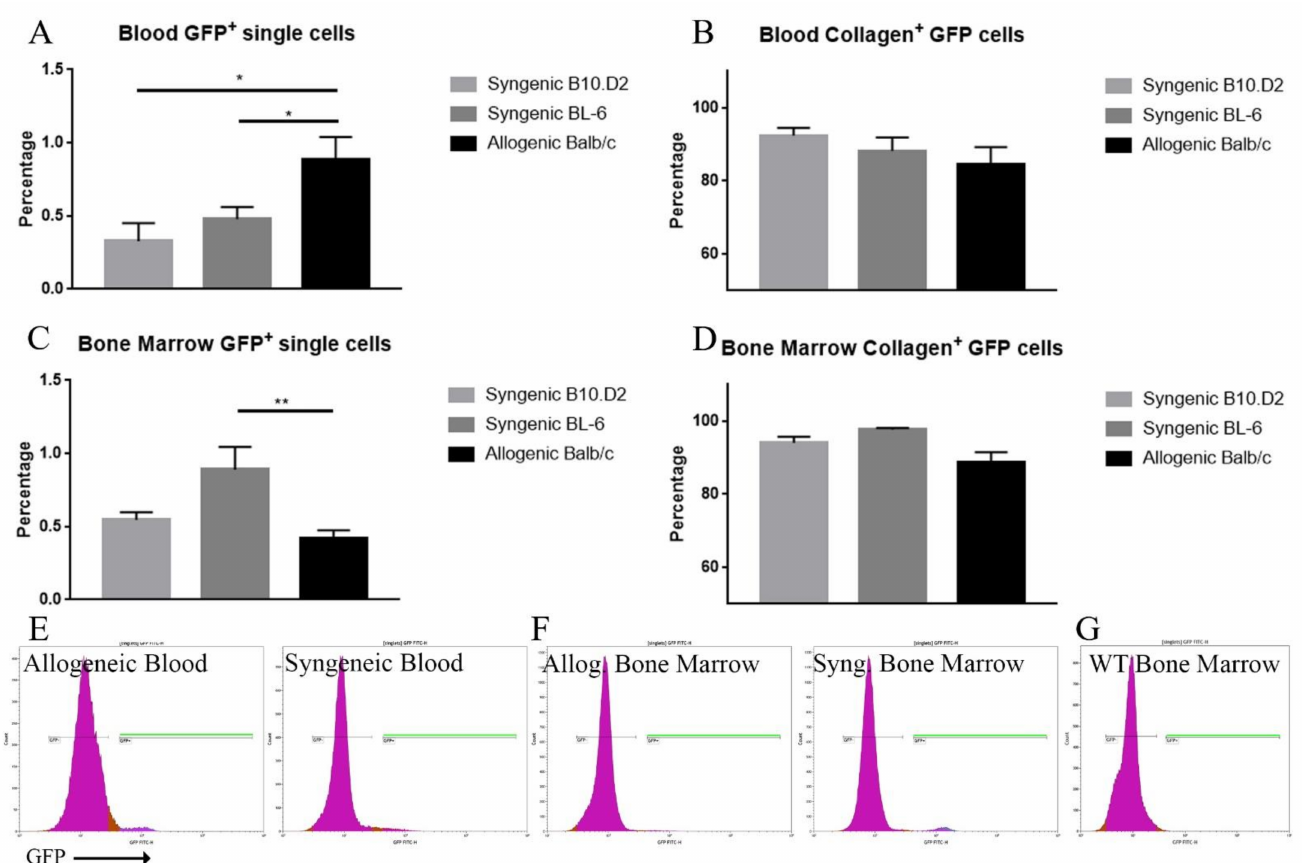
Figure 5. FACS analysis of the blood and bone marrow of the allogeneic and syngeneic models. The left side ( A , C ) depicts the percentage of GFP + cells among the single sorted cells. The right side ( B , D ) depicts the percentage of how many GFP + single cells are also collagen type I positive. While the GFP + cells in the blood were comparatively higher in the allogenic model ( A ), the opposite was the case in the bone marrow ( C ). The majority of GFP + cells were also positive for collagen type I ( B , D ). Data are presented as mean ± SEM, * p < 0.05, ** p < 0.001. Allogeneic n = 17, syngeneic BL/6 n = 17, syngeneic B10.D2 n = 10. ( E , F ) shows representative GFP signal figures. GFP + gates are highlighted in green. ( G ) Displays a wild-type control as